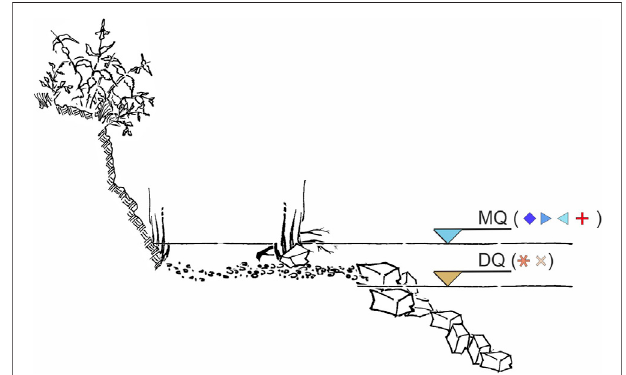
FIGURE 3 | Schematic view of the assessed bank habitat type with the indication ofthe mean water level (MQ) and the low water level (DQ) during the dewatering. Symbols behind the depth indication MQ and DQ indicate the present fi sh community composition according to Figure 6